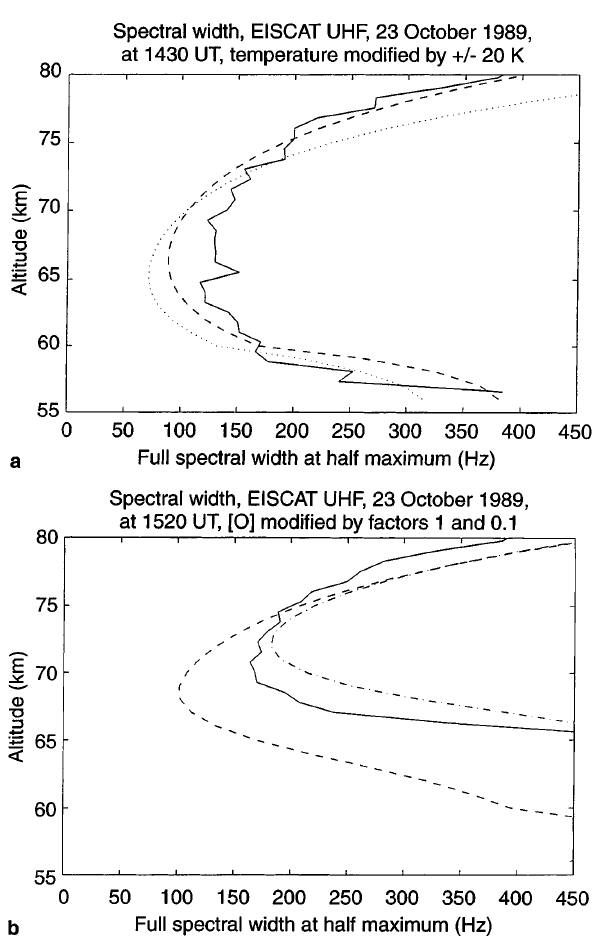
Fig. 9a, b. The e(cid:128)ect of variations in temperature a and in concentration of atomic oxygen b on the spectral width at 1430 UT and 1520 UT, respectively, on 23 October 1989. In a the temperature was varied by +20 K ( dashed line ) and by (cid:255) 20K ( dotted line ) from the value given by MSIS90. The solid line is the experimental data. In b the daytime concentration of atomic oxygen (corresponding spectralwidth given by dotted line ) was varied by a factor of 0.1 ( dash-dotted line ). Only full plasma calculation is